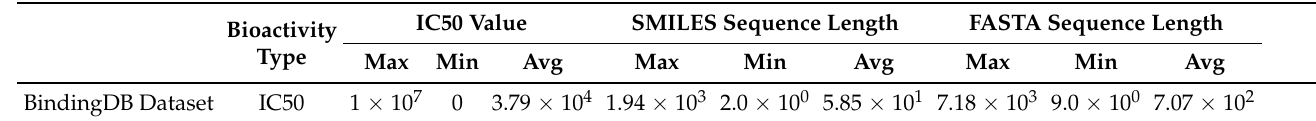
Table 2. Detailed IC50 values, lengths of SMILES characters and lengths of protein